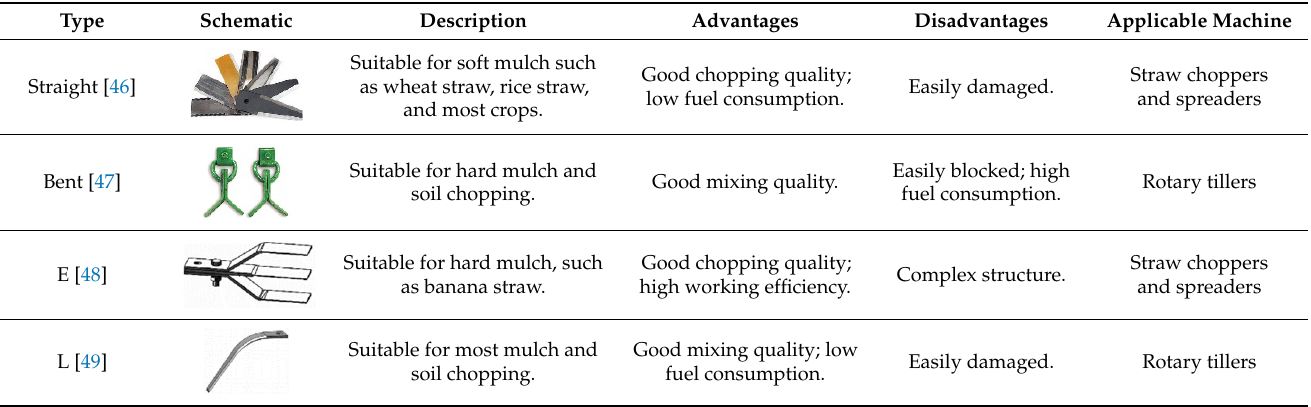
Table 8. Features of different types of blades. Figure 2. Installation angle of disc plow. ( a ) Disc plow installation angle; ( b ) ordinary type of disc plow; ( c ) vertical type of disc plow.